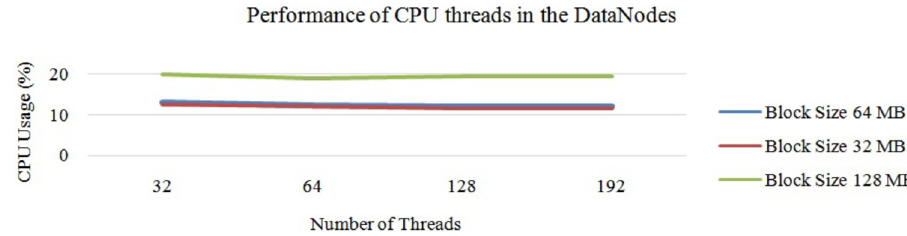
Fig 14. Performance of Hadoop on each DataNode for large data with different block